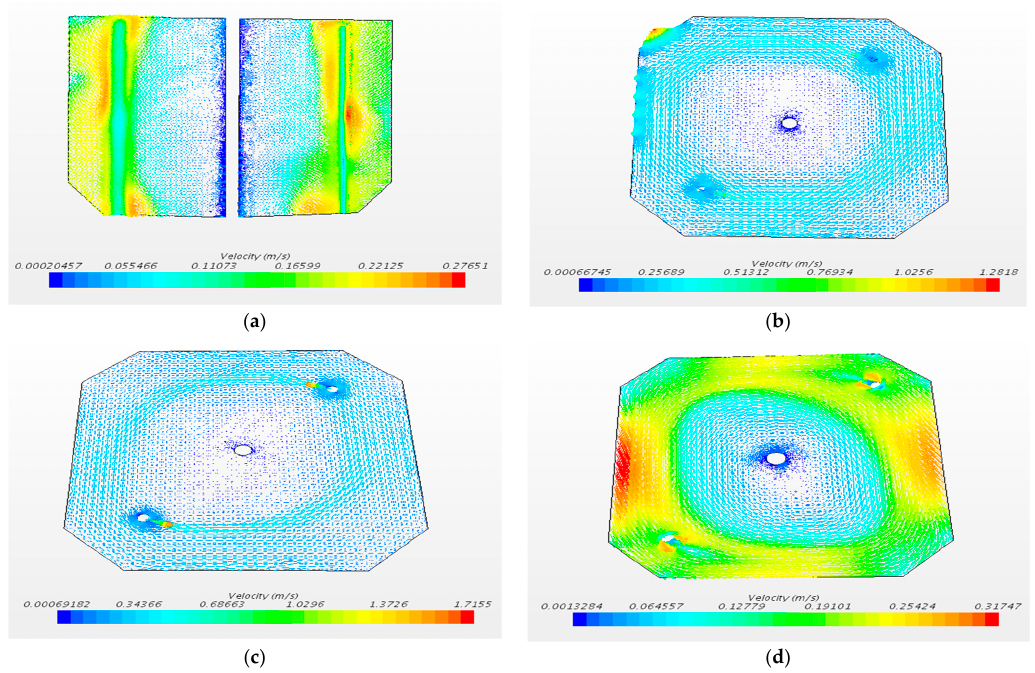
Figure 14. ( a ) middle longitudinal section, ( b ) H = 16.5 m cross section, ( c ) H = 8.5 m cross section, ( d ) H = 1.5 m cross section. (4) Bottom outflow ratio of 10%